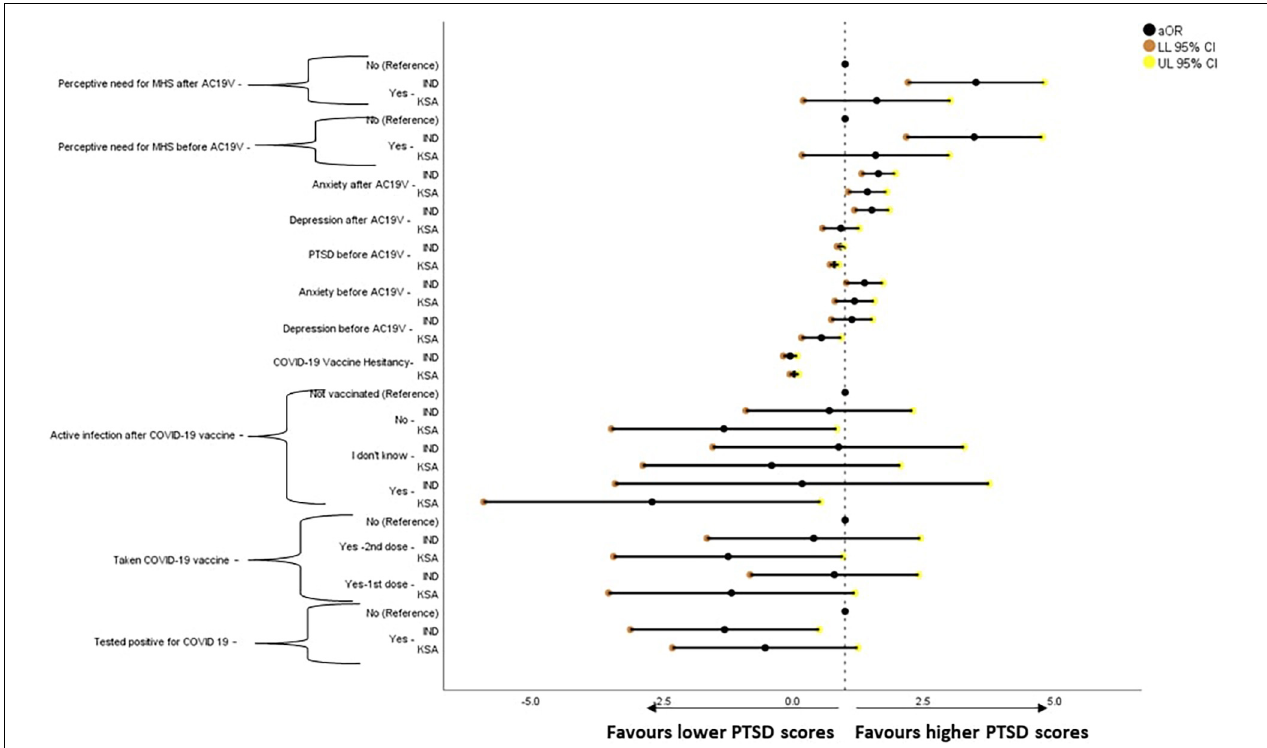
FIGURE 7 | Forest plot showing adjusted generalized linear regression analysis of post-traumatic stress disorder scores (regression model 2). aOR, adjusted Odds Ratio; Odds ratio adjusted for Sociodemographic factors. 95% CI, 95% Confidence Interval. The results of regression model 1, 2, and 3 in binary logistic regression analysis of depression scores is tabulated in Supplementary Table 14 . Ind–India; KSA–Kingdom of Saudi